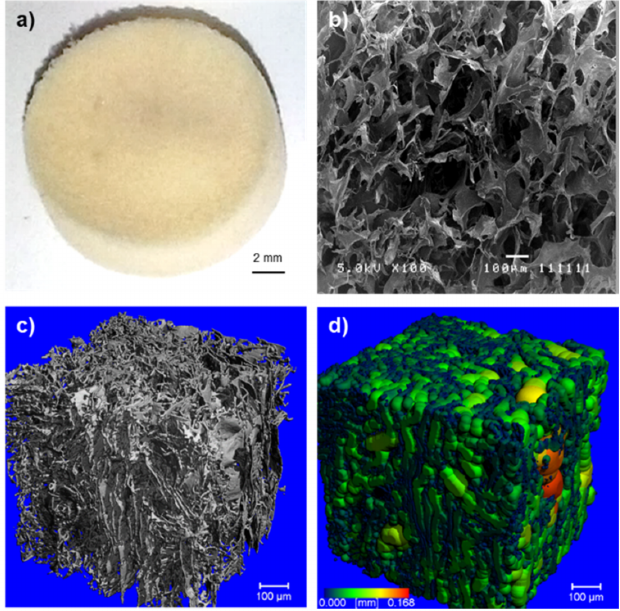
Figure 1. Characterization of the crosslinked keratin–alginate sponge. ( a ) Representative picture of the sponge (scale bar: 2 mm). ( b ) Scanning electron microscopy image of the sponge. ( c ) Three- dimensional (3D) microCT rendering of the sponge and ( d ) the heat map representation of pore diameters within a defined